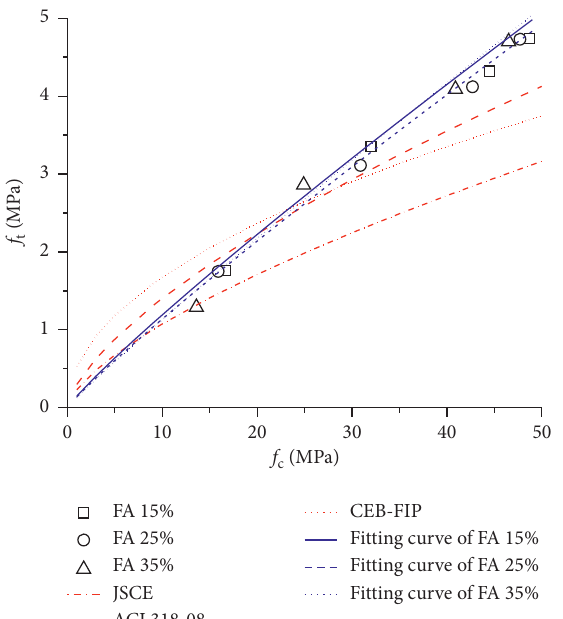
Figure 8: Comparison of the tensile models and the fitting